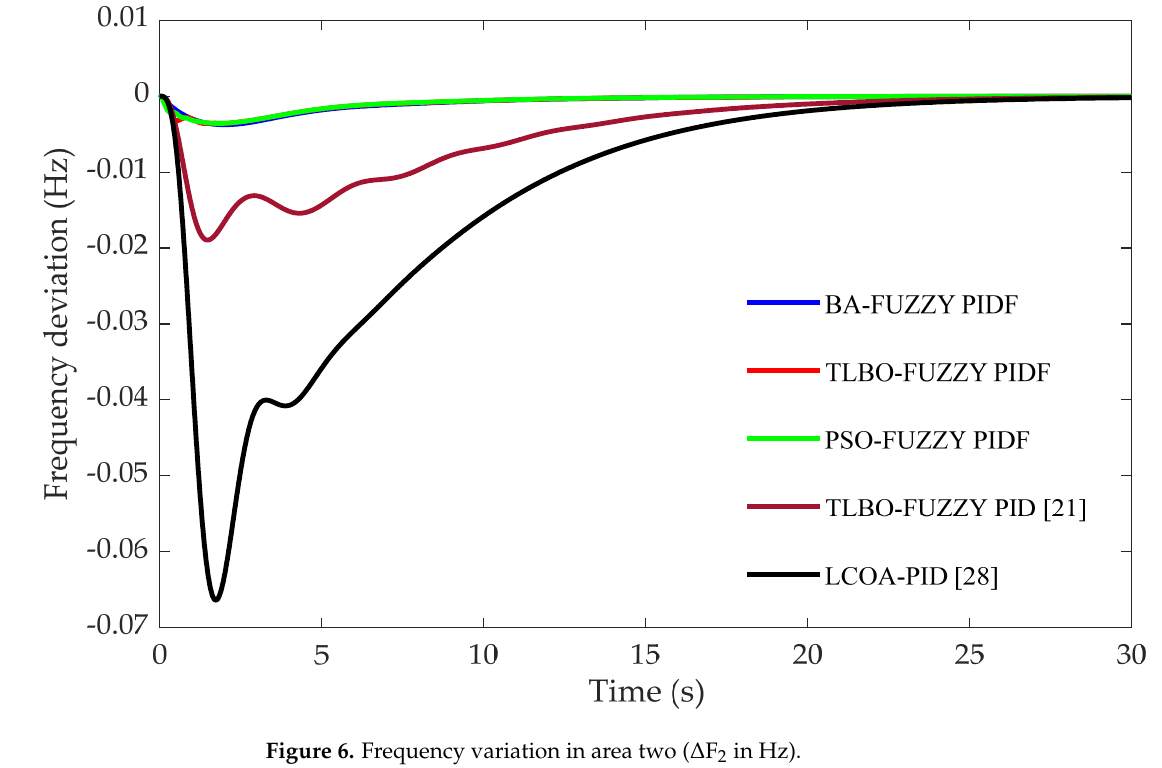
Figure 5. Frequency variation in area one ( ∆ F 1 in Hz).